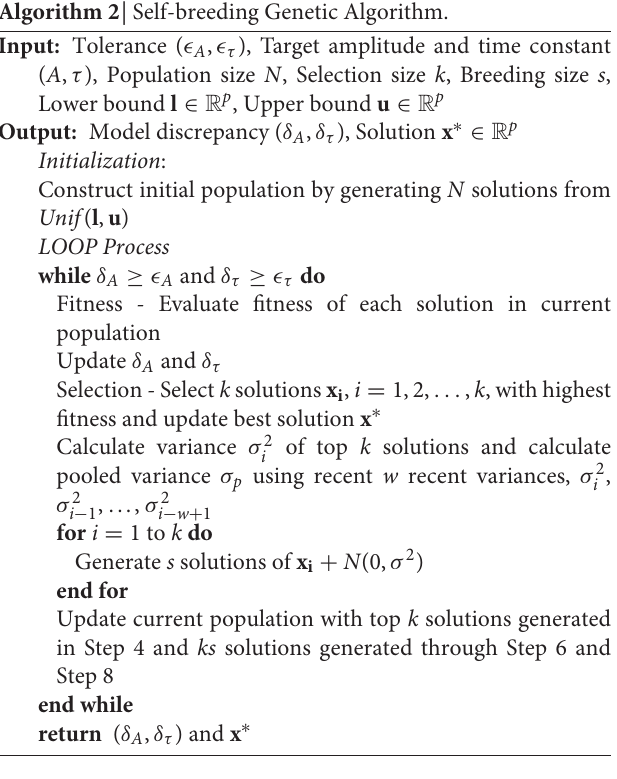
Algorithm 2 | Self-breeding Genetic